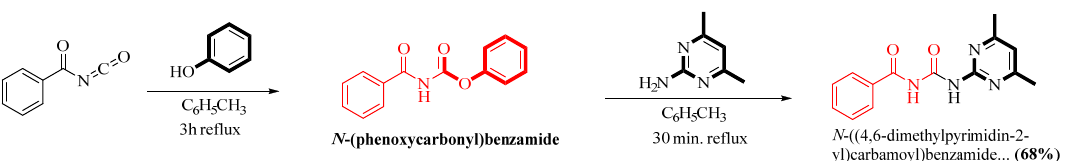
Table 2. Some Molinspiration/OSIRIS predicted pharmacokinetic properties. Calculated partition coefficients (cLogP values) were Octanol/H 2 O based.